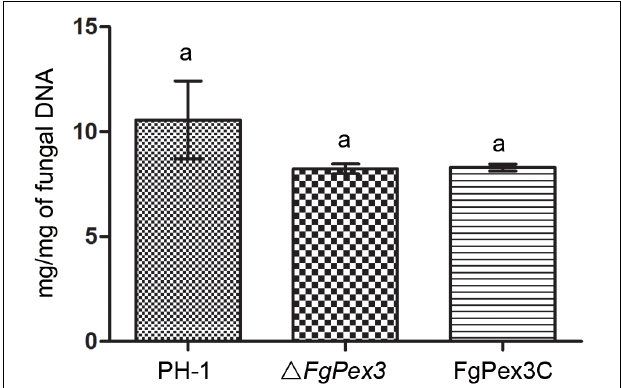
FIGURE 7 | DON production of the wild-type, mutant and complemented strain on infected rice kernels. Values on the bars followed by the same letter indicate no significant difference at P =